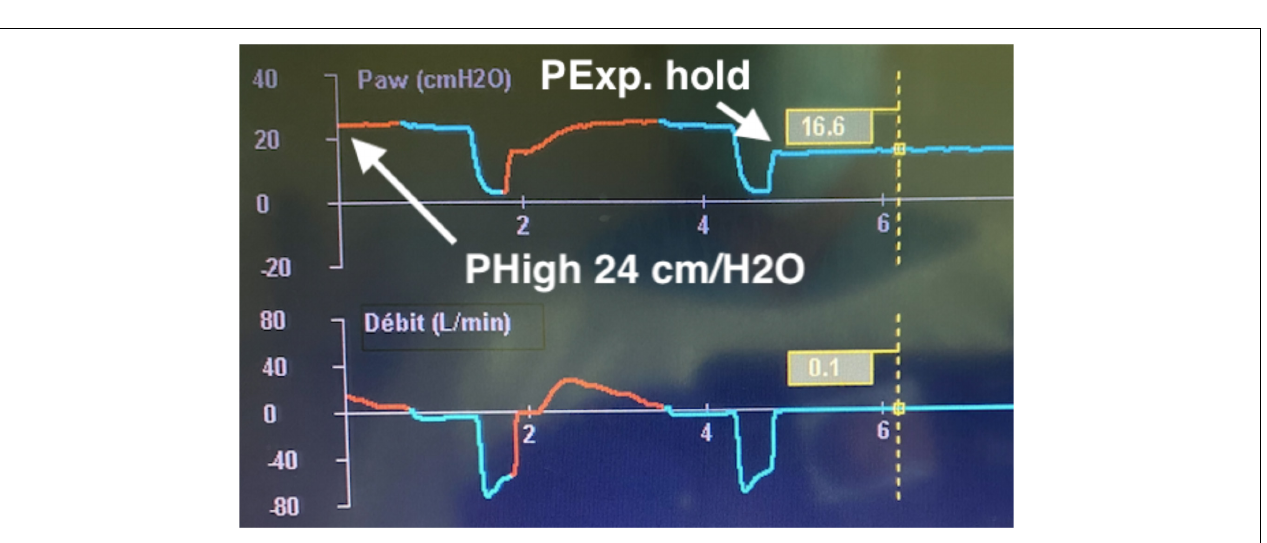
FIGURE 2 | Calculation of Effective PEEP/Driving pressure: an expiratory hold is performed and equilibration of pressure occurs. This is the effective PEEP. Driving pressure is PHigh – PExpiratory hold, in this case approximately 7–8